Question: Give a one-sentence summary of this figure.
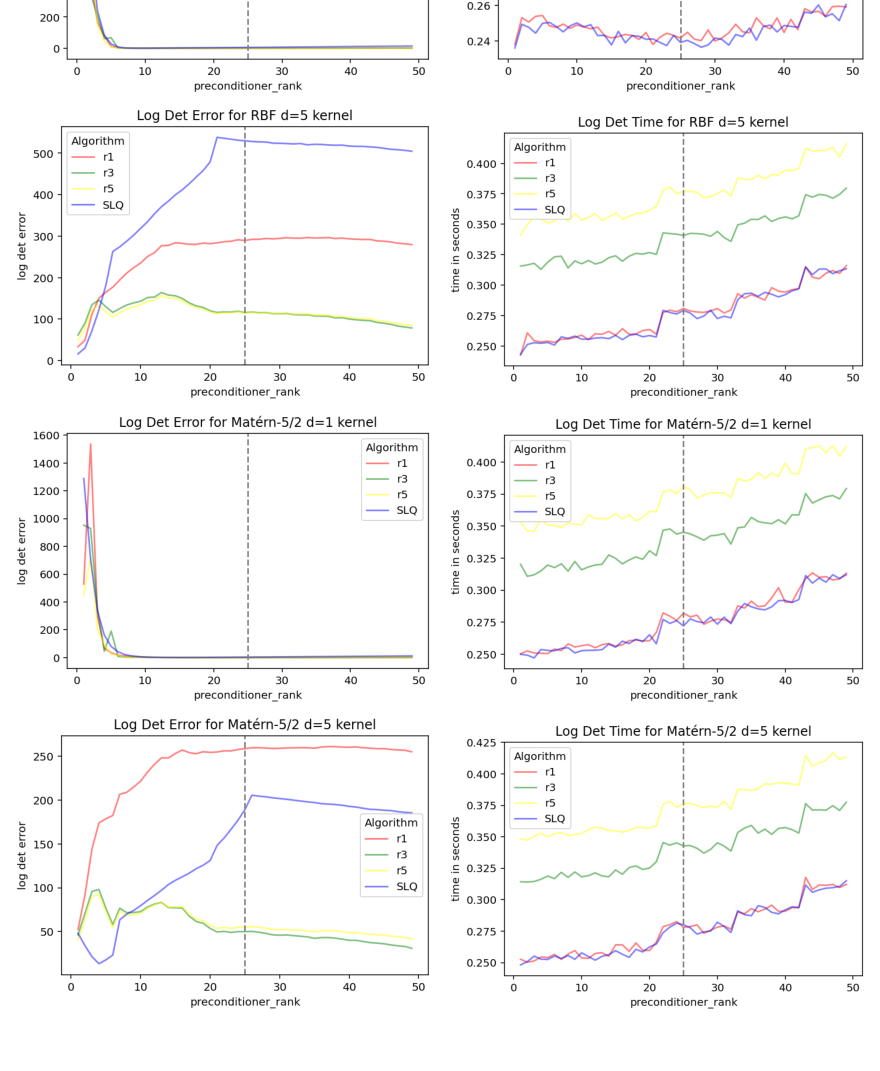
Answer: Comparison of log det algorithms when run with differently sized preconditioners. All measurements are averages over 100 randomly generated kernels with n = 20, 000 as measured on a NVidia A100 GPU.